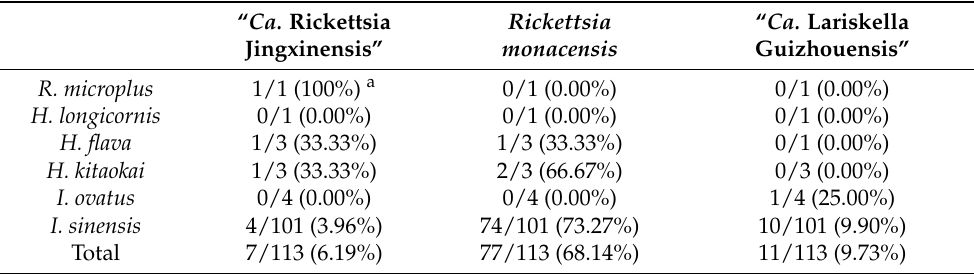
Table 1. Prevalence of Rickettsia and “ Candidatus Lariskella guizhouensis” in different tick species from Guizhou Province.